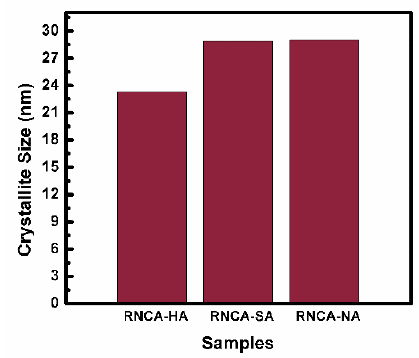
Figure 9. Crystallite sizes of RNCA Samples.